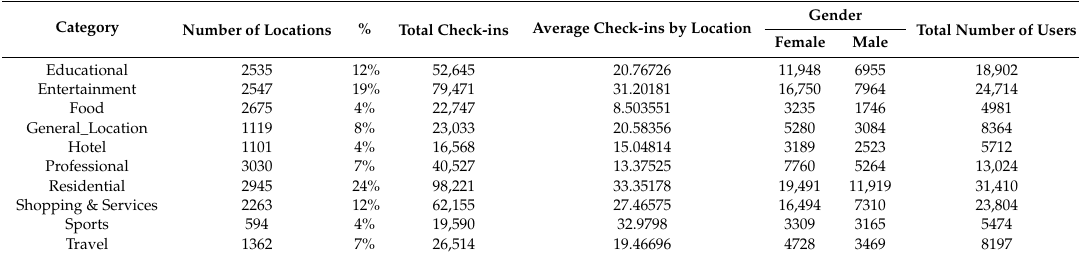
Table 2. Attributes of